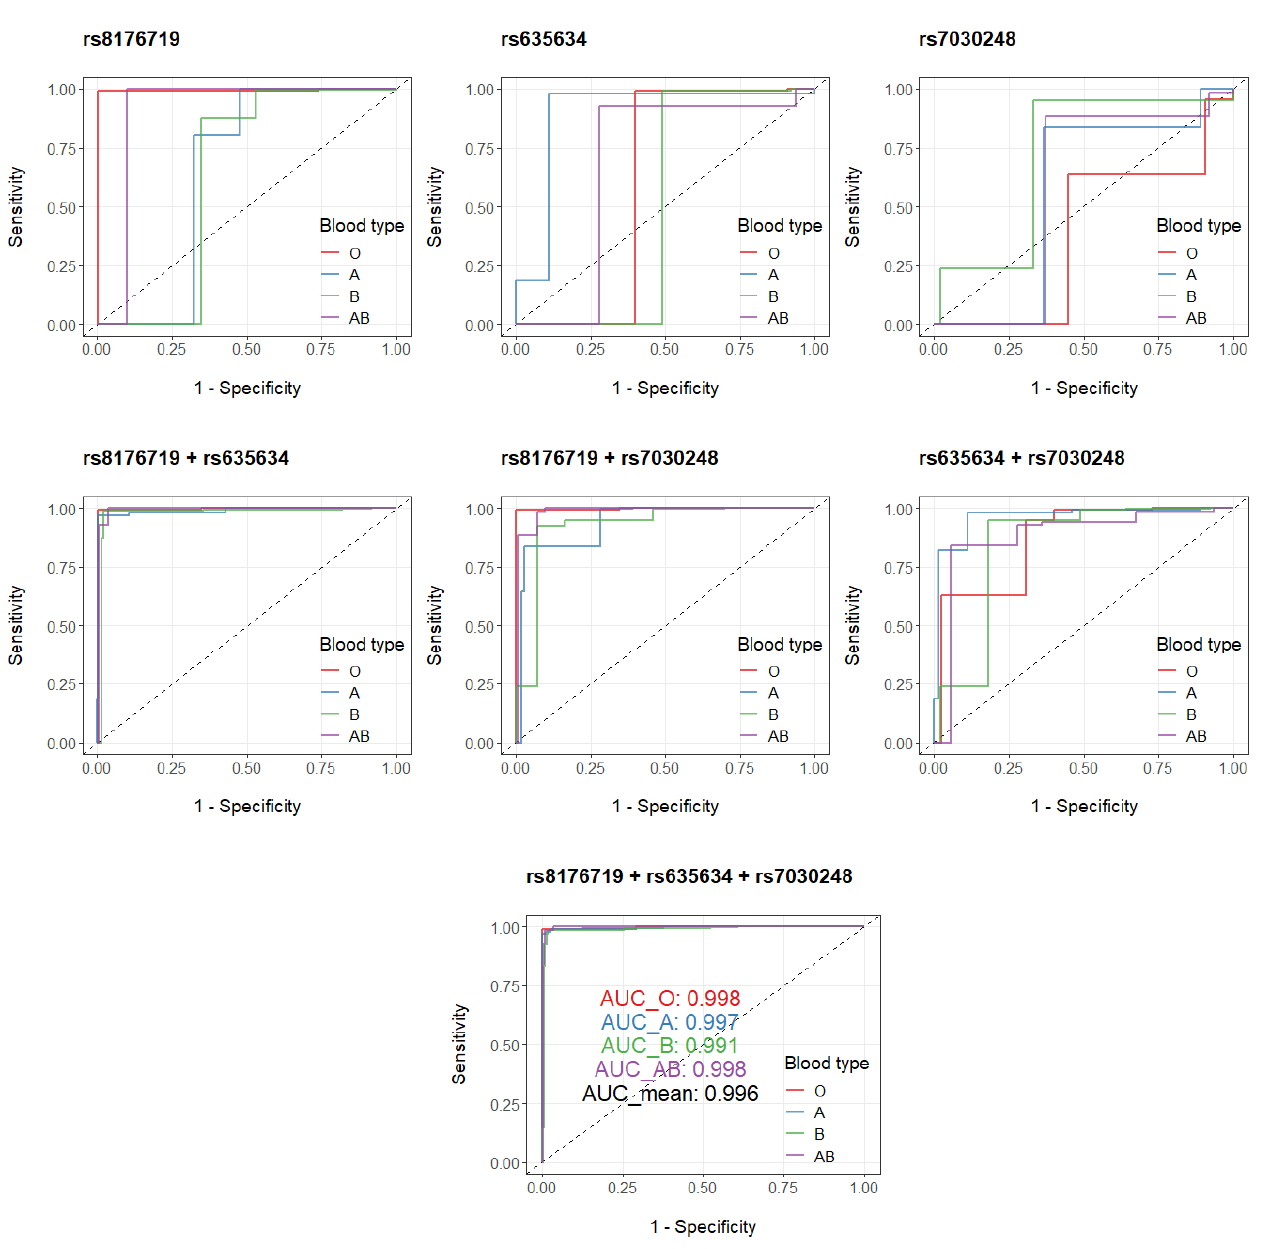
Figure 3. By-blood-type ROC plots for rs8176719 , rs635634 , rs7030248 and their combinations. AUC: area under the curve.